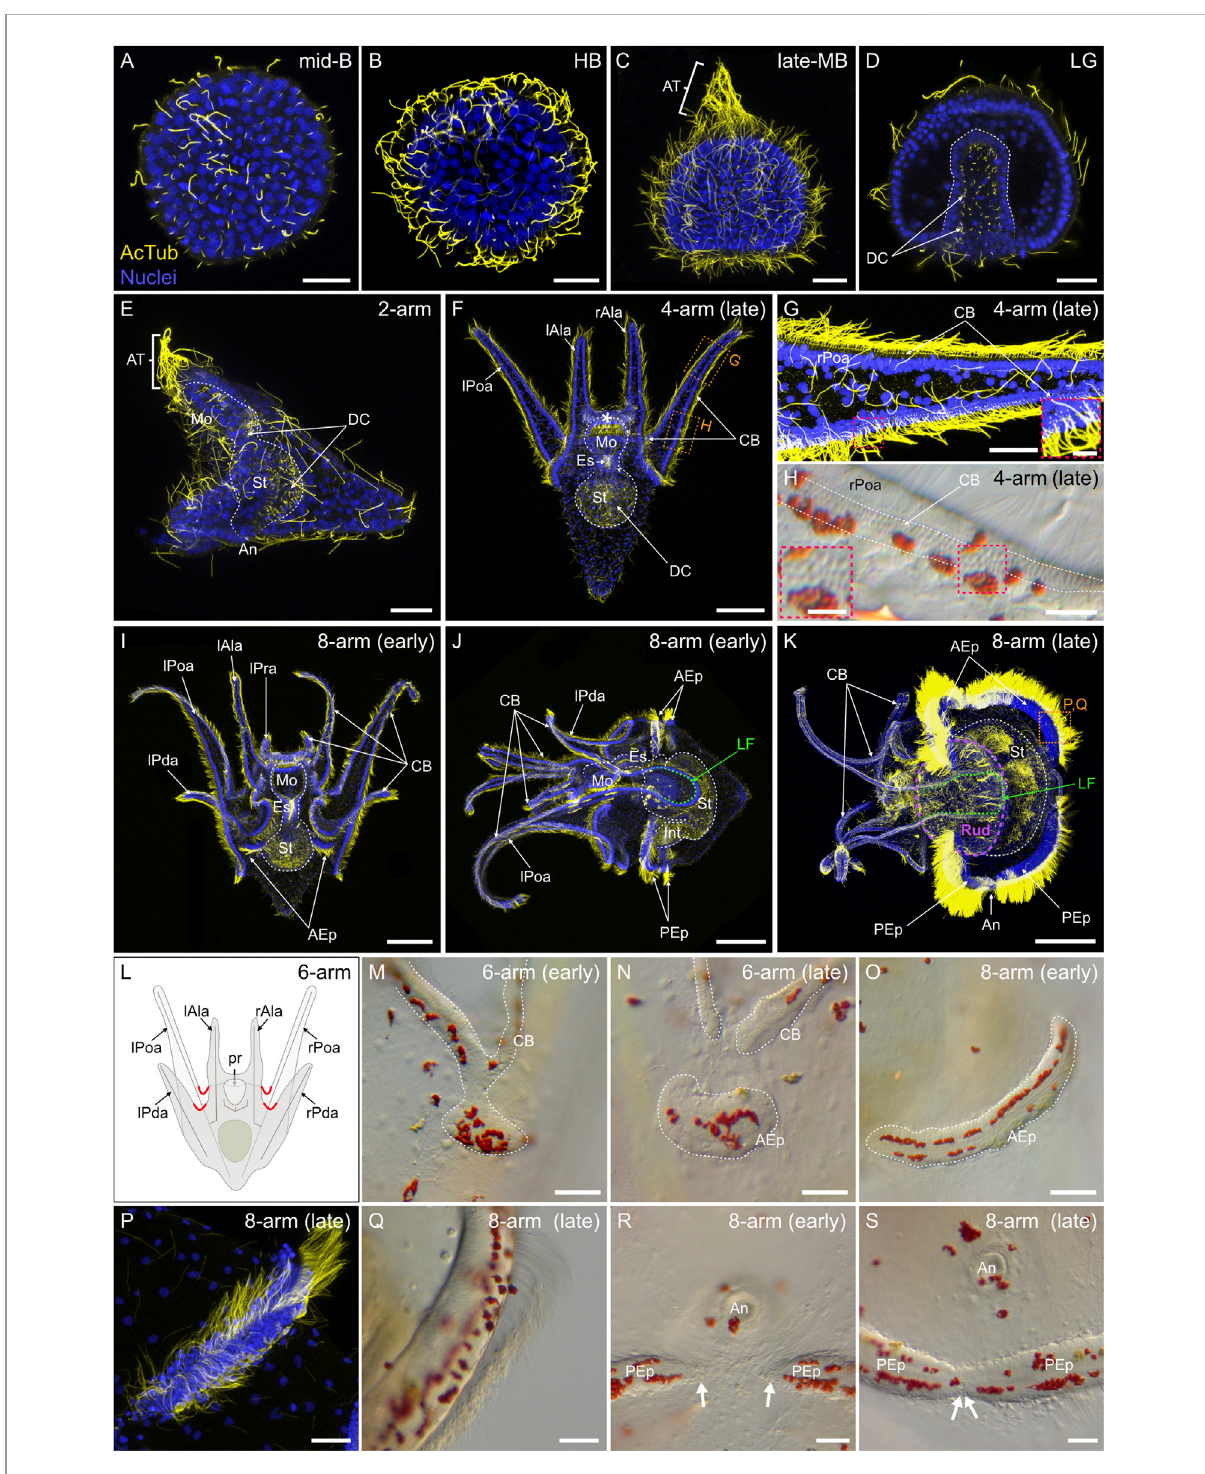
FIGURE 8 Ciliogenesisin Paracentrotuslividus during theembryonicand larvalperiods.Developmentalstagesareas follows: (A) mid-blastulastage(mid- B); (B) hatched blastula stage (HB); (C) late mesenchyme blastula stage (late-MB); (D) late gastrula stage (LG); (E) 2-arm pluteus stage (2-arm); (F – H) 4-arm pluteus stage (4-arm); (I – K, O – S) 8-arm pluteus stage (8-arm); (L – N) 6-arm pluteus stage (6-arm). The use of (early) or (late) associated